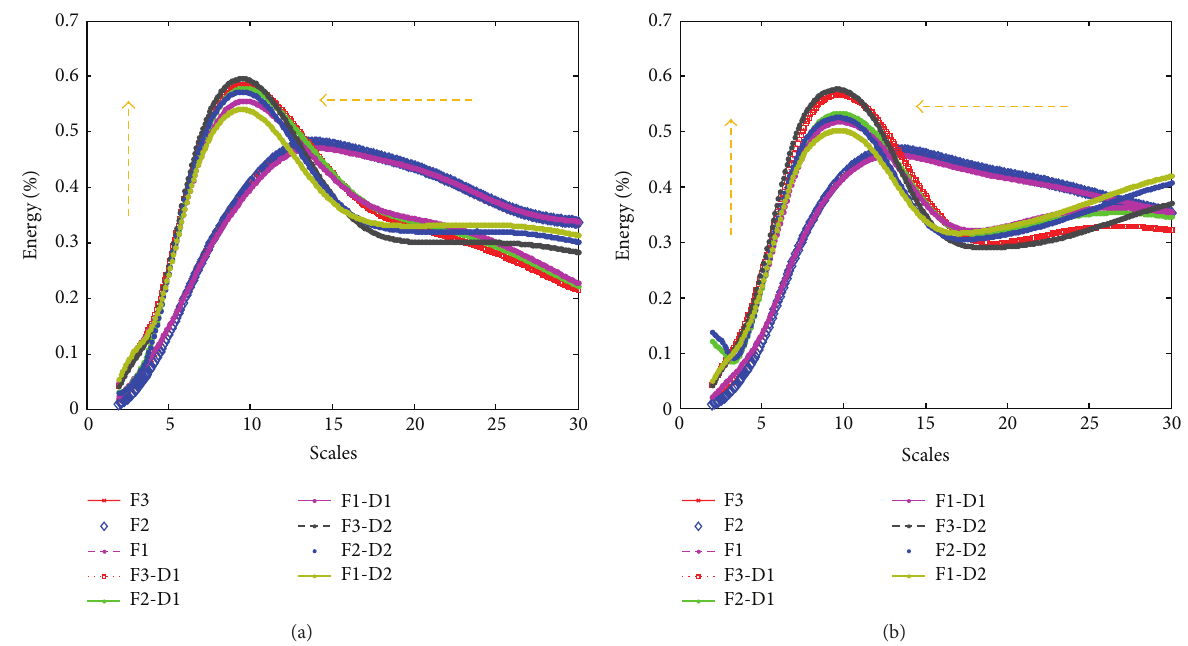
Figure 6: Total wavelet energy of (a) regular and (b) irregular buildings.